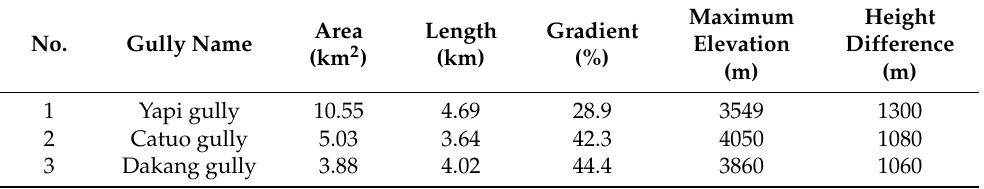
Table 1. Geometrical features of the gullies in the Yapi gully, Catuo gully, and Dakang gully.